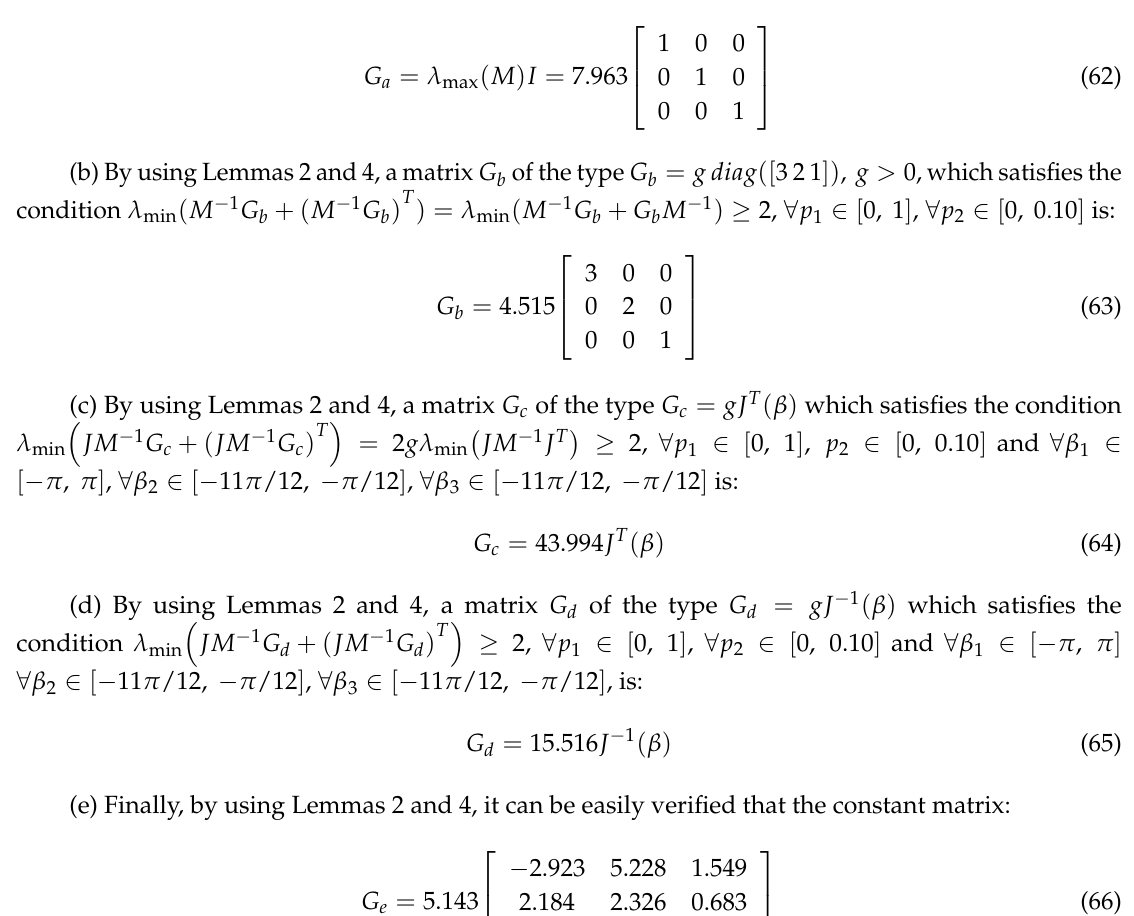
 in the joint space. Figure 17. Time histories of r ( t ) and . r ( t ) in the joint and ( ) r t β β  